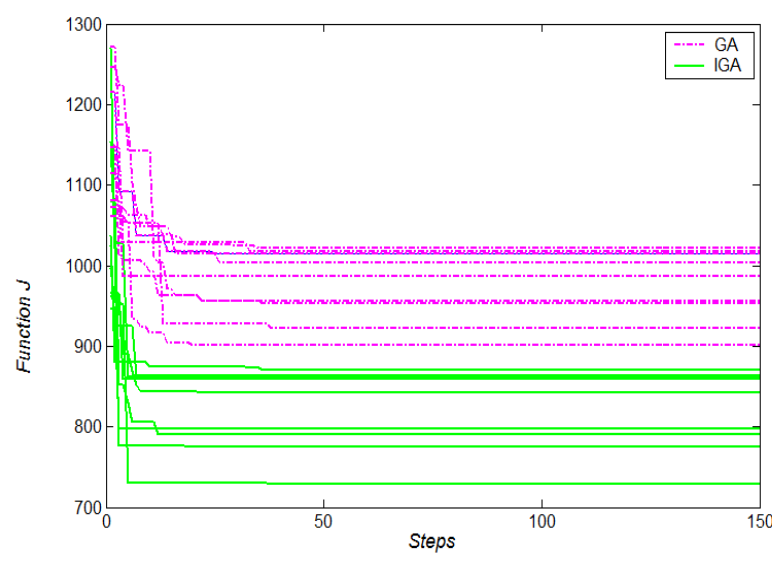
Figure 4. The optimization process of the cost function of the improved genetic algorithm (IGA). Table 1. The minimum of objective function.